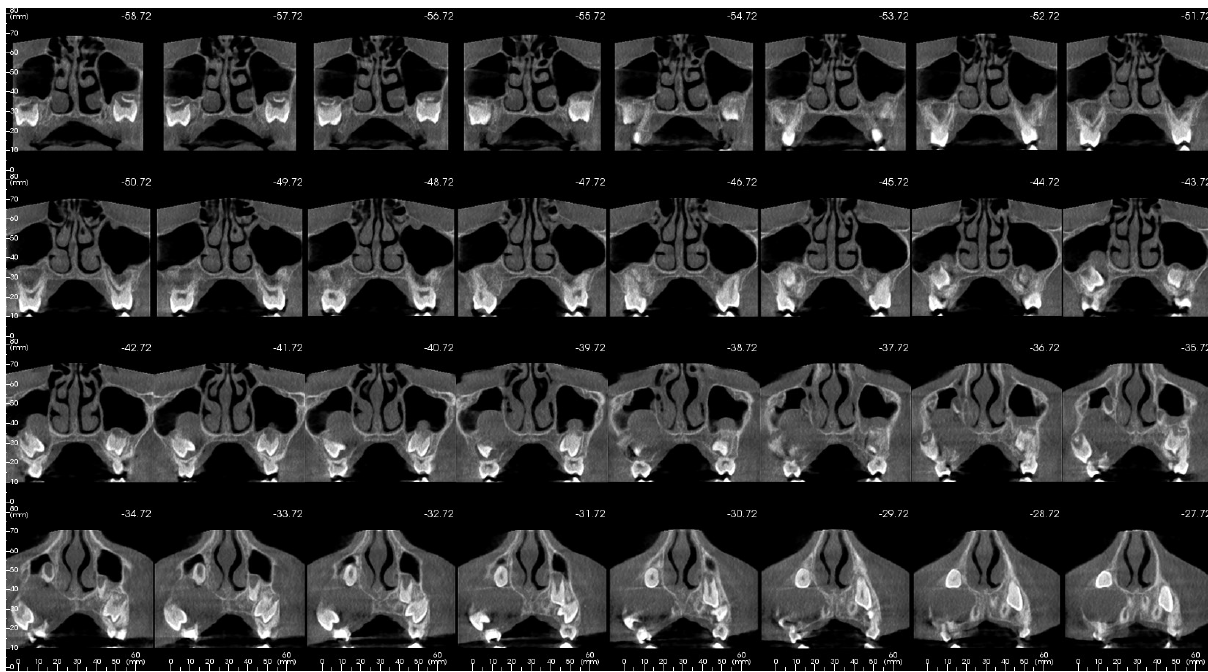
7 of 16 Figure 4. CBCT before treatment—sagittal view.